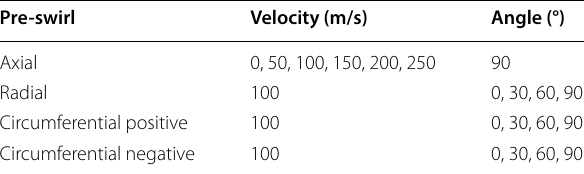
Table 5 Pre-swirl parameters